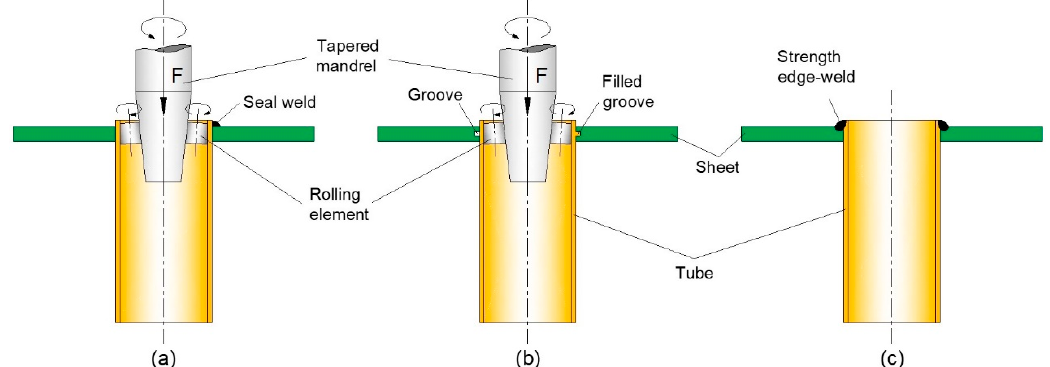
Figure 1. Commonly used processes for attaching metal sheets to metal tube ends: ( a ) Expansion with a roller without (left) and with (right) seal welding; ( b ) Expansion with a roller using sheet holes with machined grooves; ( c ) Strength fusion welding.